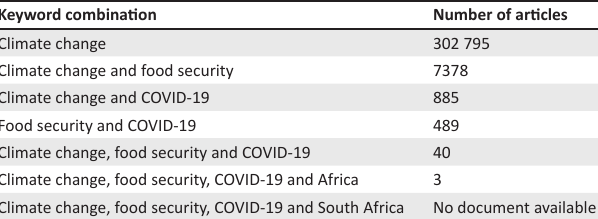
TABLE 1: A summary of articles